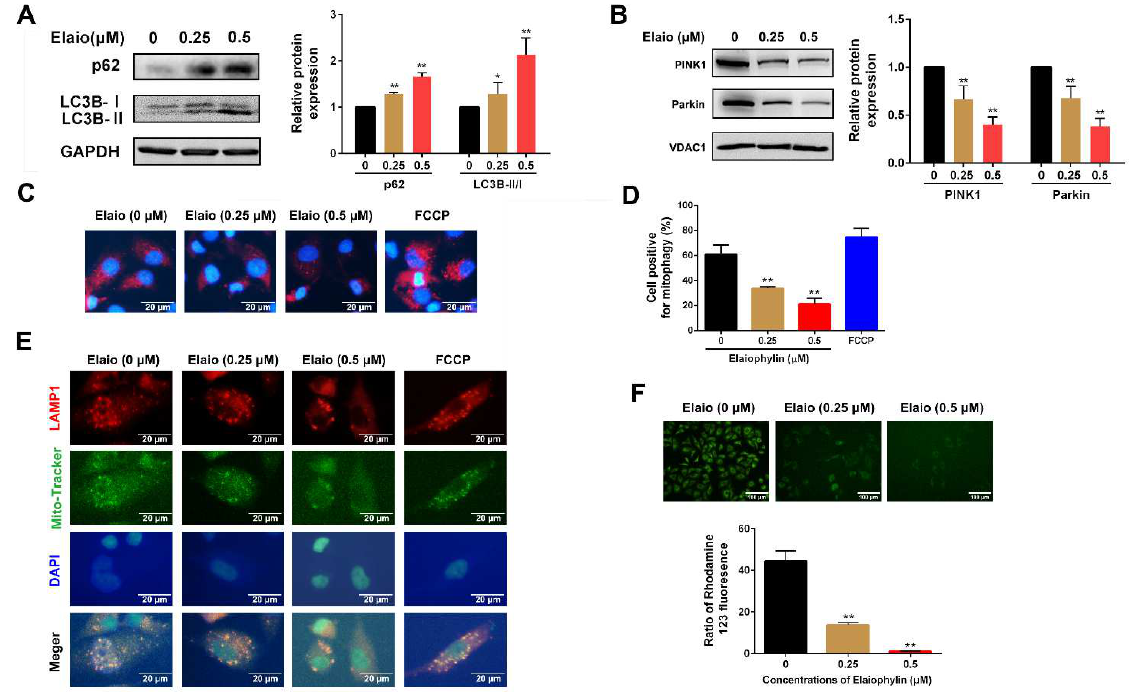
Figure 3. Elaiophylin inhibits mitophagy and induces mitochondrial dysfunction in A549 cells. A549 cells were exposed to elaiophylin or FCCP (a mitophagy agonist) for 24 h. ( A ) The expression of autophagy-related proteins (LC3B and SQSTM1 (p62)) was assessed by Western blot analysis. ( B ) The expressions of mitophagy-related proteins (PINK1 and Parkin) were assessed by Western blot analysis. ( C , D ) A549 cells overexpressing Mito-Keima plasmid were treated with elaiophylin for 24 h. Mito-Keima (red fluorescence) was detected by a fluorescence microscope. FCCP, a mitophagy agonist, was used as a positive control. ( E ) Co-localization of mitochondria and lysosomes was assessed by MitoTracker (200 nM) and LAMP1 co-staining. ( F ) Mitochondrial membrane potential was assessed by rhodamine 123 staining. Data were expressed as means ± SD of three experiments and each experiment included triplicated repeats. * p < 0.05, ** p < 0.01 vs. control. Original Western Blots can be found at supplementary materials.